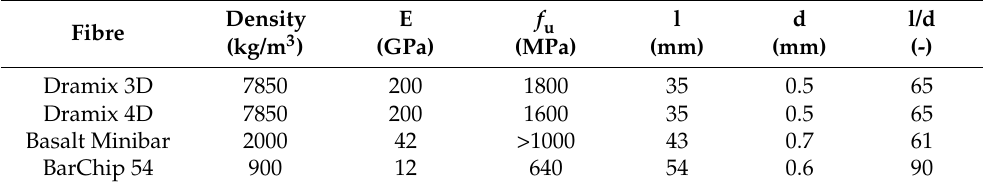
Table 5. Mechanical properties and geometry of fibres.